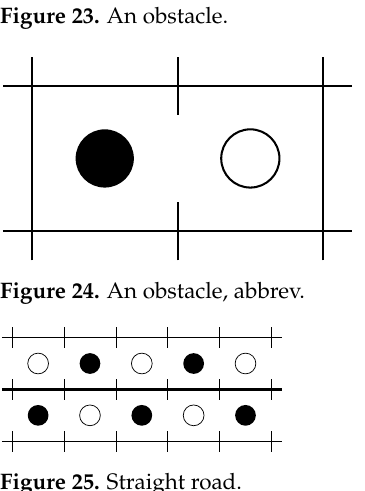
Figure 25. Straight